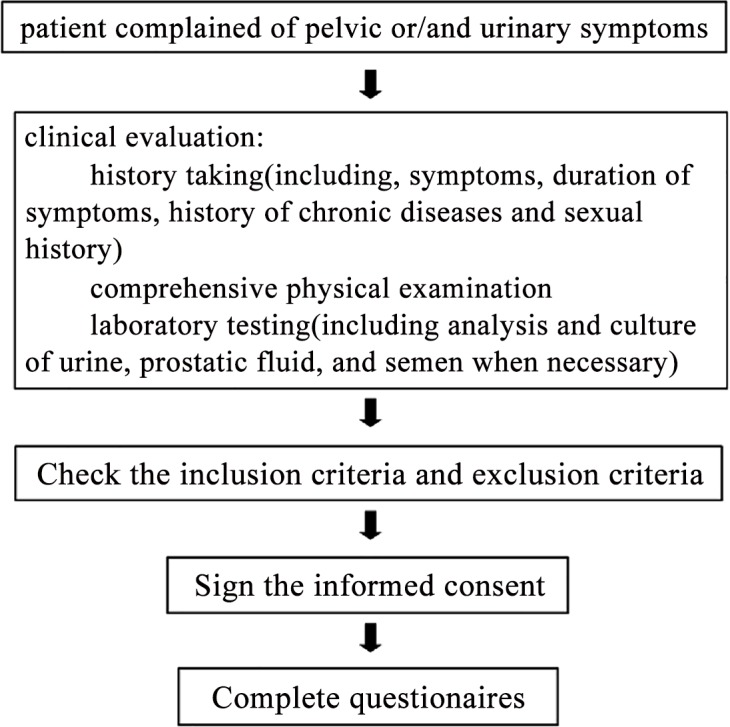
Study flowchart for patients enrollment.